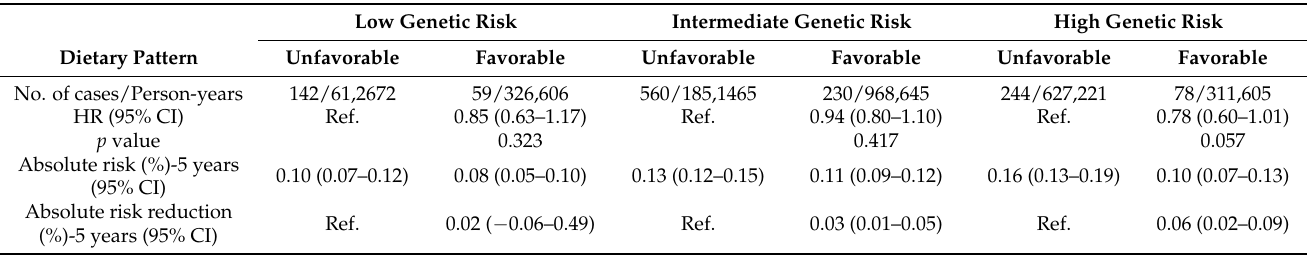
Table 4. UGI cancer risk associated with healthy diet by genetic risk level in the UKB cohort 1